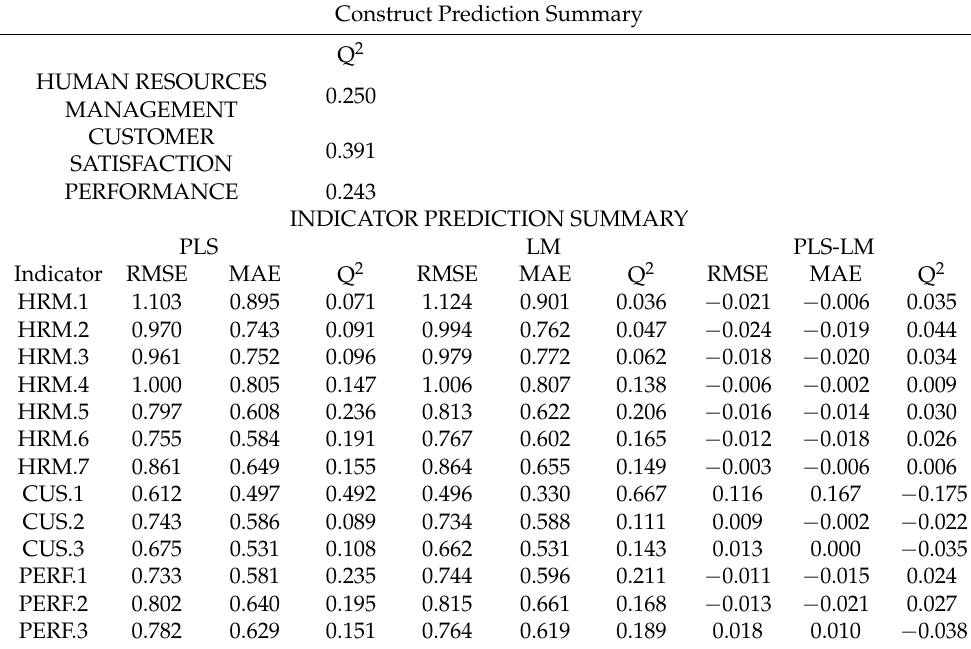
Table 5. PLS predict